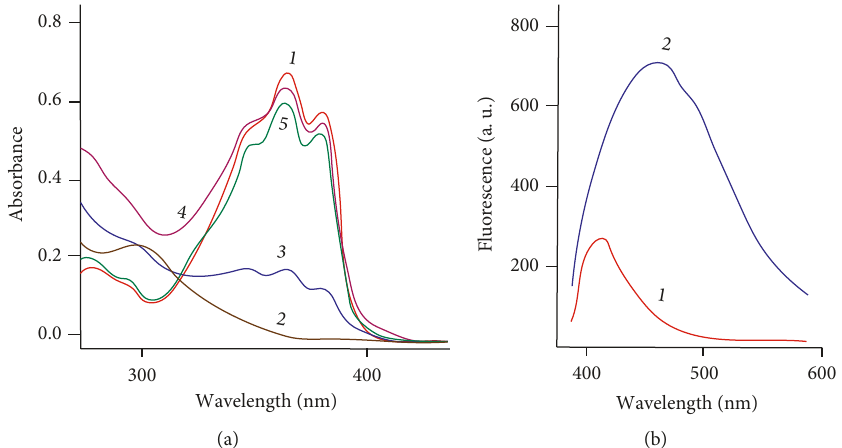
Figure 4: Electronic spectra of 3 in acetonitrile ( 2 0 · 10 − 5 M ). (a) Absorption before ( 1 ) and after addition of F − ( 3 ), CN − ( 2 ), AcO − ( 4 ), and − ( 5 ) ( 2 0 · 10 − 4 M ). (b) Fluorescence before ( 1 ) and after addition of F − ( 2 ). PO H 2 4